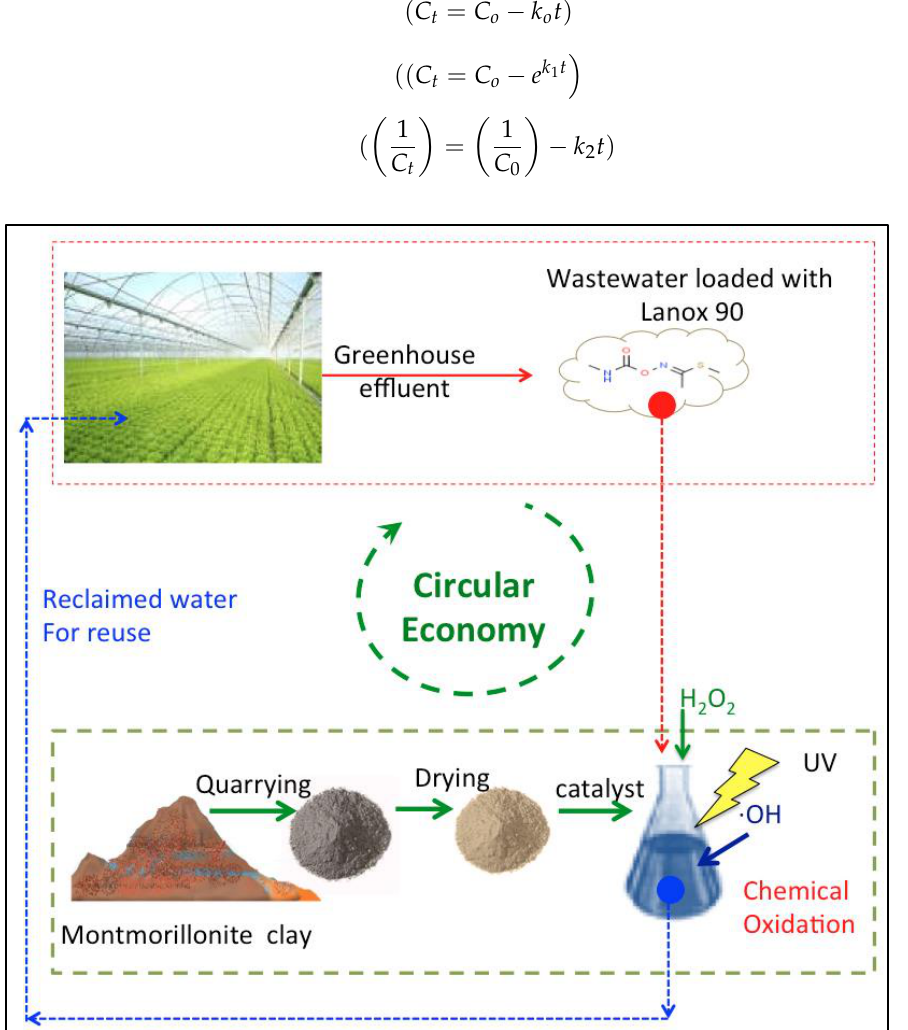
Figure 1. Graphical representation of agricultural wastewater effluent management.